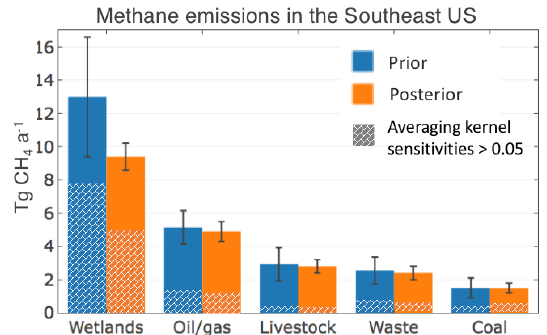
Figure 5. Prior and posterior methane emissions in the Southeast US (domain of Fig. 1) for August–September 2013. The prior an- thropogenic emissions are from the EPA national inventory for 2012 (EPA, 2016; Maasakkers et al., 2016) and the prior wetland emis- sions are the means of the WetCHARTs extended ensemble (Bloom et al., 2017). Error bars (one standard deviation) on sectoral emis- sions are from the prior and posterior error variances of our inver- sion. Methane emissions in the subdomain with averaging kernel sensitivities larger than 0.05 (Fig. 1) are also